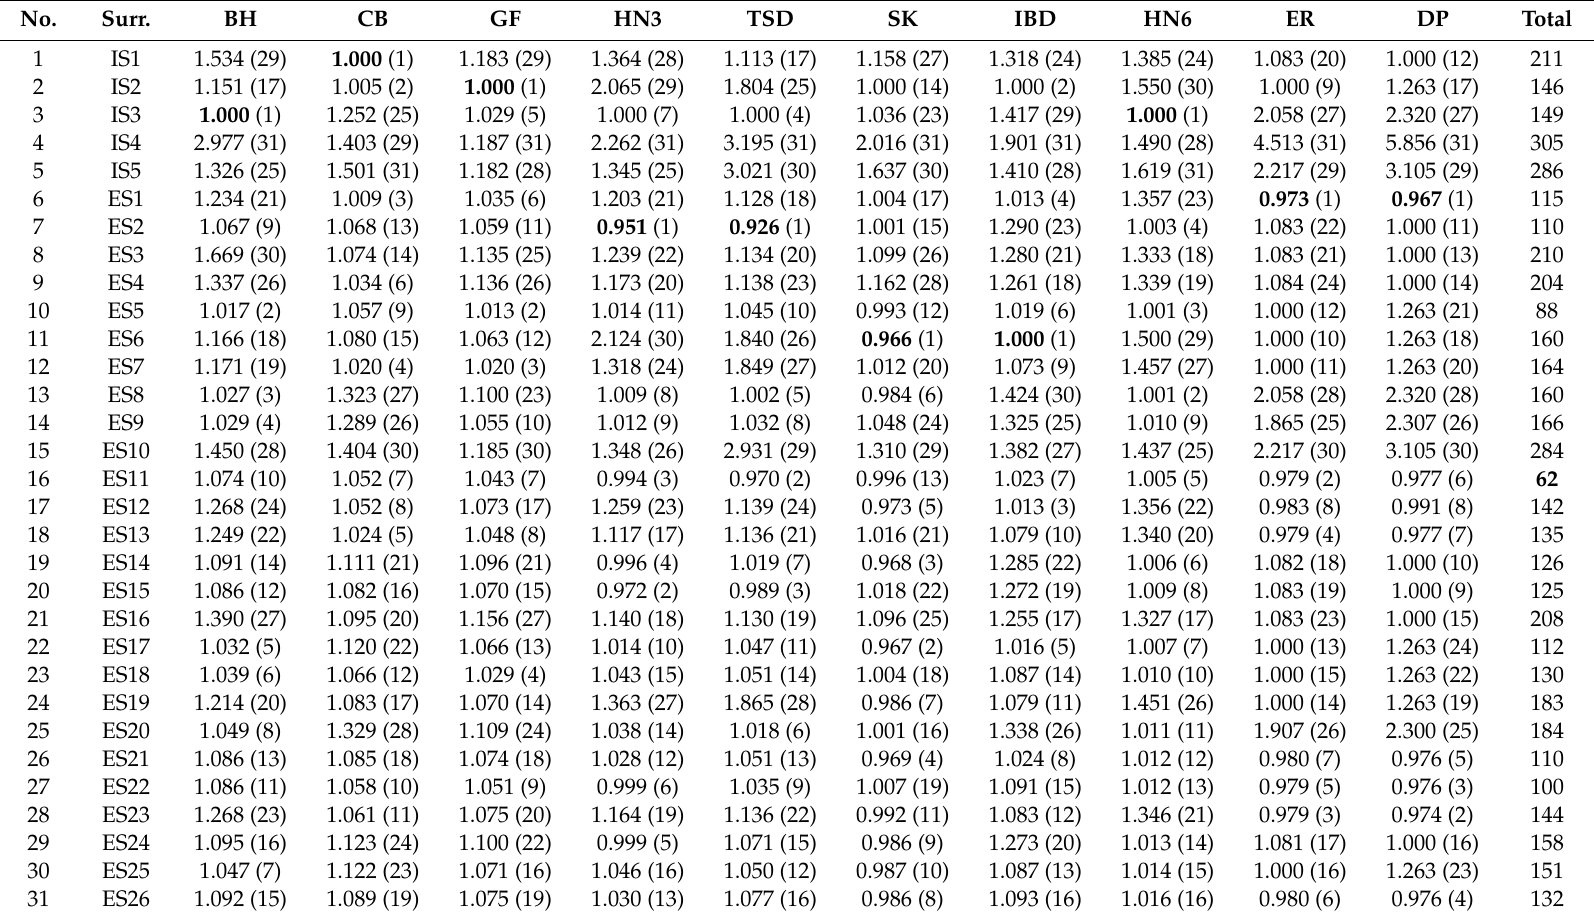
Table 4. Comparison of performance measure root mean square error (RMSE) for all test